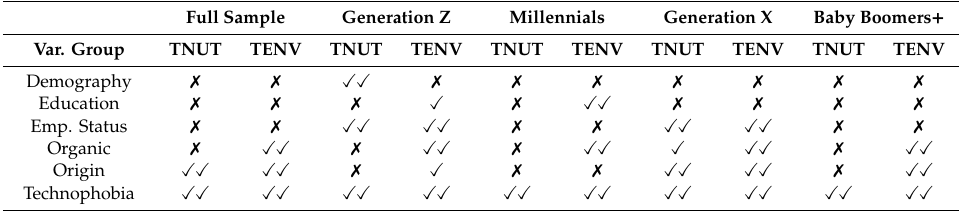
Table 9. Summary of the findings of the generation analysis *. Full Sample Generation Z Millennials Generation X Baby Boomers